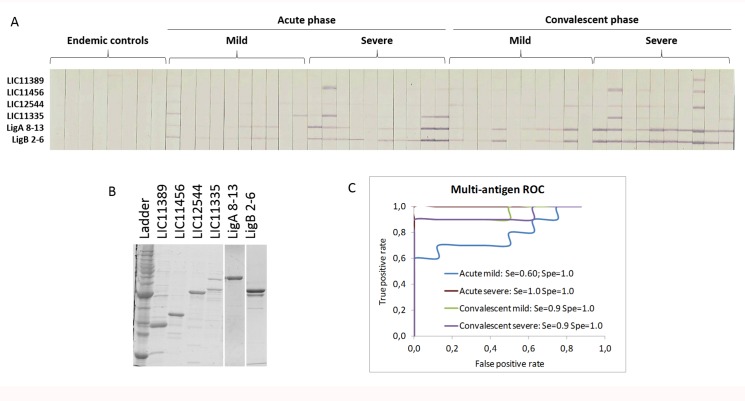
Validation of microarray results by MAPIA.(A) MAPIA strips probed for specific IgG in leptospirosis patients and endemic controls. Strips are grouped by disease severity, in acute and convalescent phases. (B) SDS PAGE of the 6 purified recombinant proteins that were applied to MAPIA strips. (C) ROC curves of the combination of all 6 antigens are shown for mild and severe groups at both acute and convalescent phases.